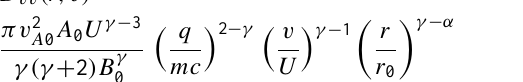
Fig. 3. The (normalized) approximated self-consistent velocity dif- fusion coefficient given by Eq.(3).